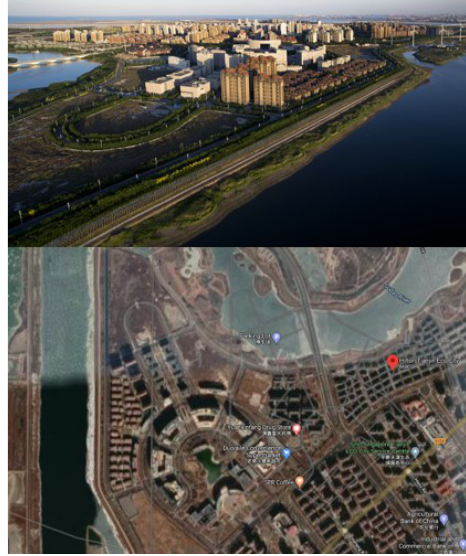
Figure 5. The view of Tianjin from the riverside and the location map (Source: Google